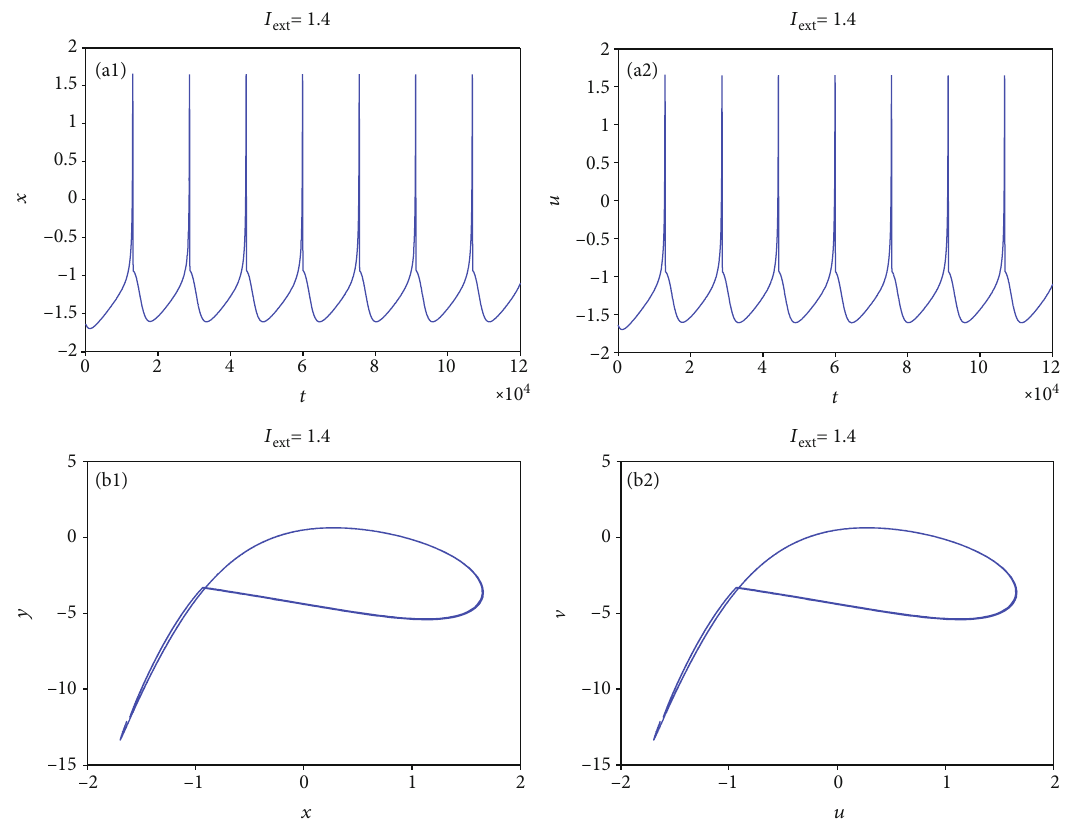
Figure 1: Period-1 fi ring pattern of model (2) when I Phase